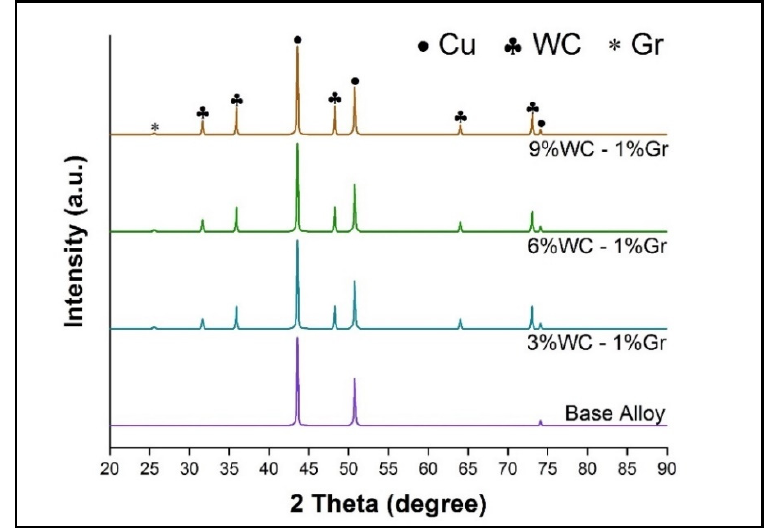
Figure 8. XRD phase analysis of Cu alloy and Cu-(3, 6, 9) wt.% WC-Gr hybrid composites.